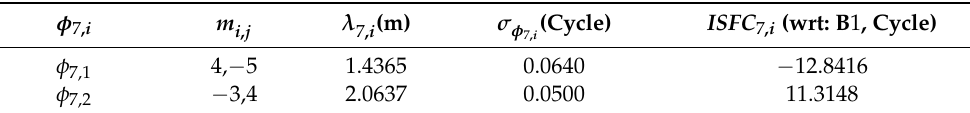
Table 1. The optimized phase combinations of dual-frequency